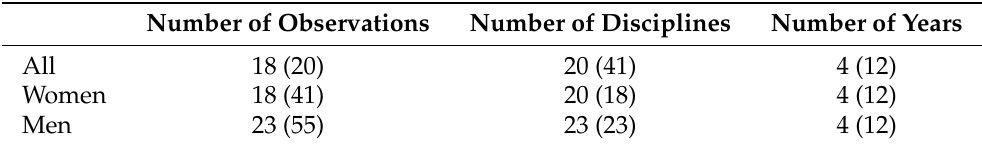
Table 1. Summary related to the number of disciplines, the number of observations, and the number of years for the two scenarios considered: Olympic years and all disciplines (in